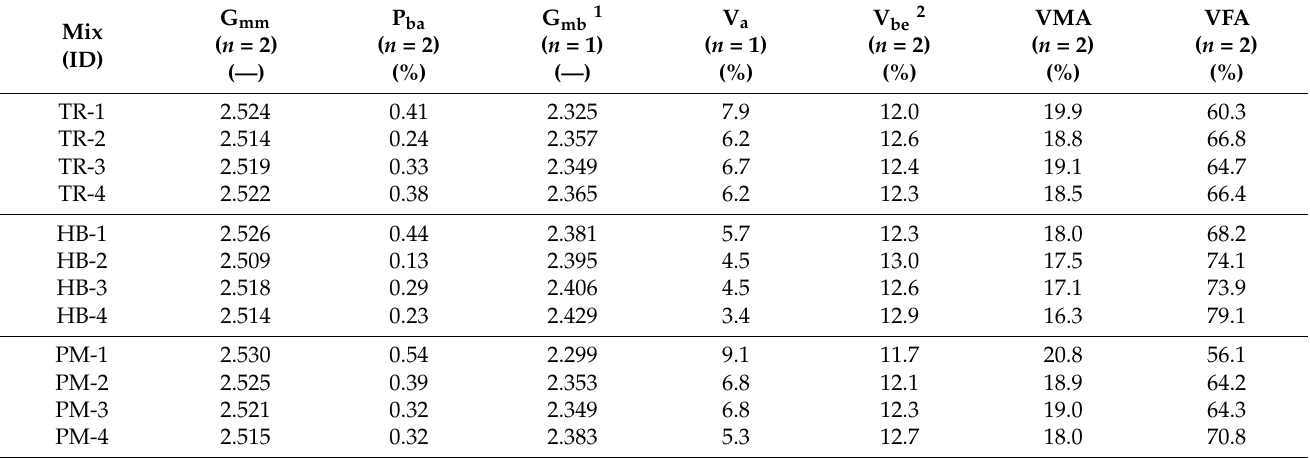
Table 5. Volumetric